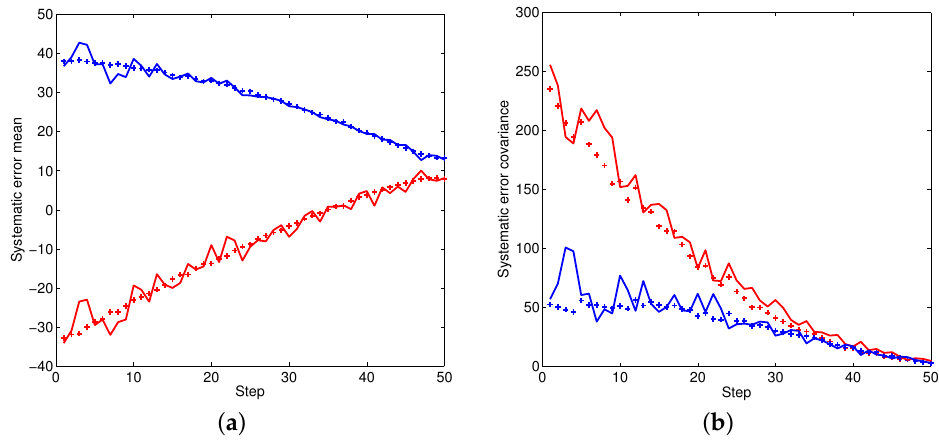
Figure 4. The statistic properties of the systematic error for object three. ( a ) Mean of systematic error; ( b ) Covariance of systematic error.